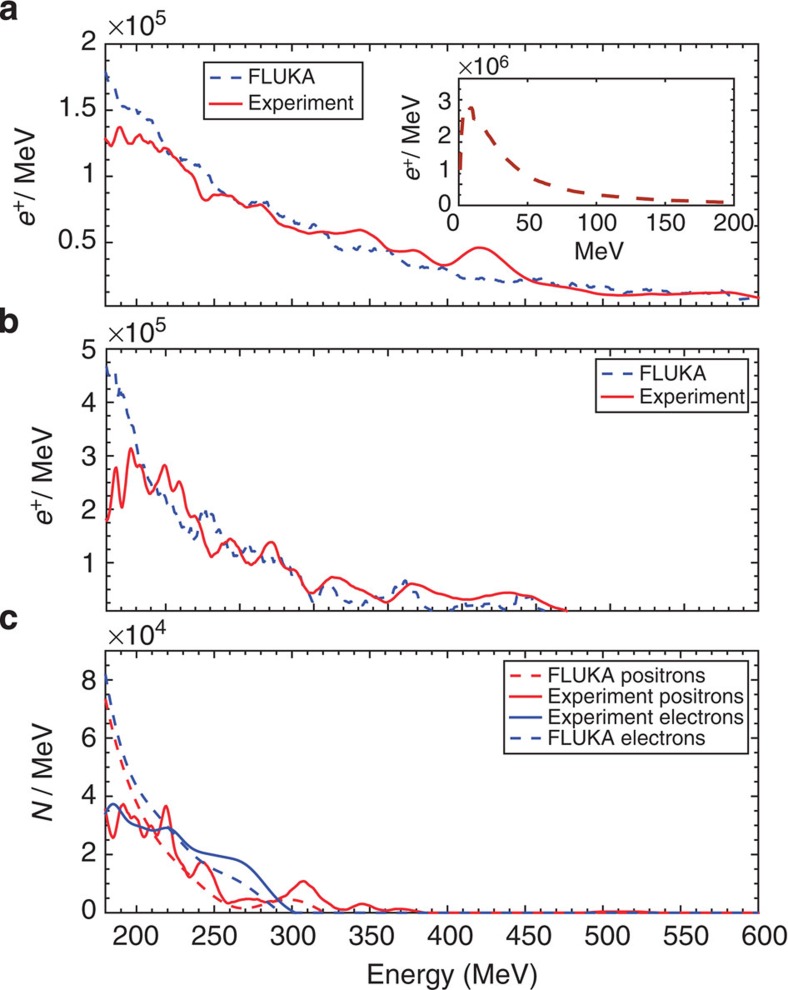
Positron spectra.Measured positron spectra, as resulting from the average over five consecutive shots, (solid lines) compared with that obtained from FLUKA simulations (dashed lines) for d=5 mm (a), d=2 cm (b) and d=4 cm (c). In this latter case, also the spectrum of the electrons escaping the target is plotted. Its similarity with the positron spectrum is a clear indication of the generation of a neutral electron–positron pair beam. The inset in a shows the simulated positron spectrum at low energy for d=5 mm, indicating a Jüttner–Synge distribution.